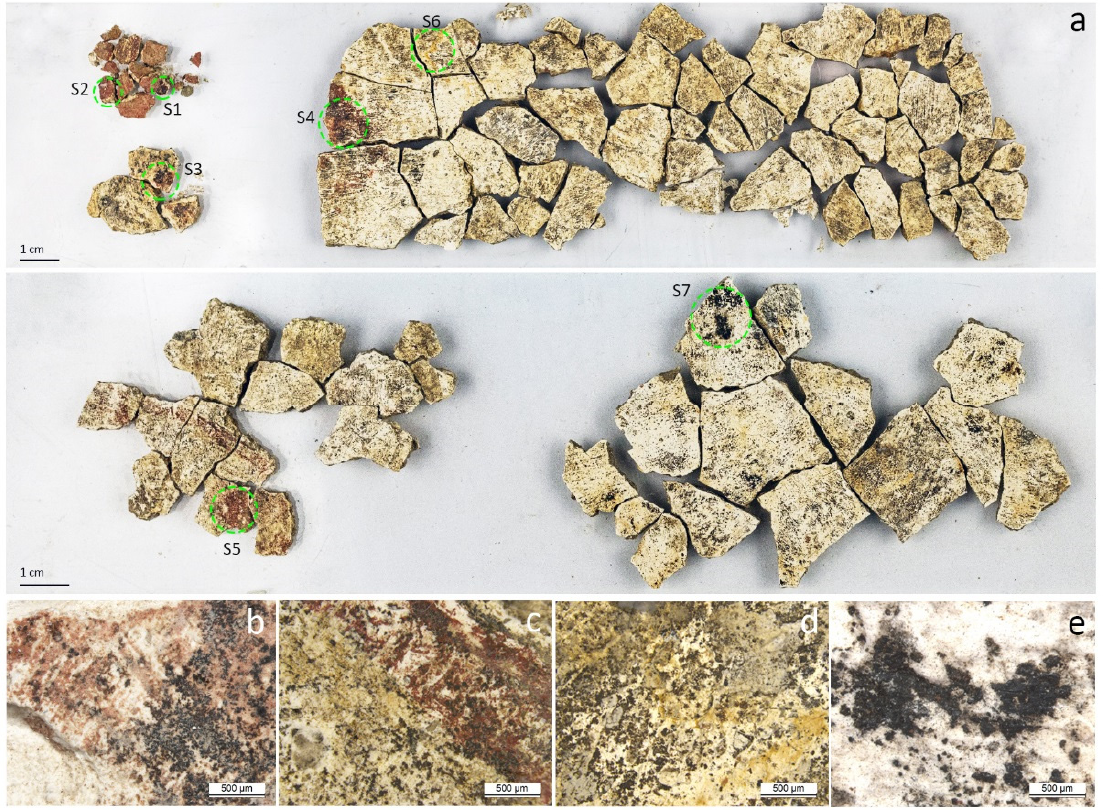
Figure 2. Wall painting fragments discovered at Alburnus Maior (analyzed spots are indicated in the figure) ( a ); microscopic details of some of the investigated pigmented areas: red mixed with black, sample S4 ( b ); red mixed with yellow, sample S5 ( c ); yellow, sample S6 ( d ); and black, sample S7 ( e ).